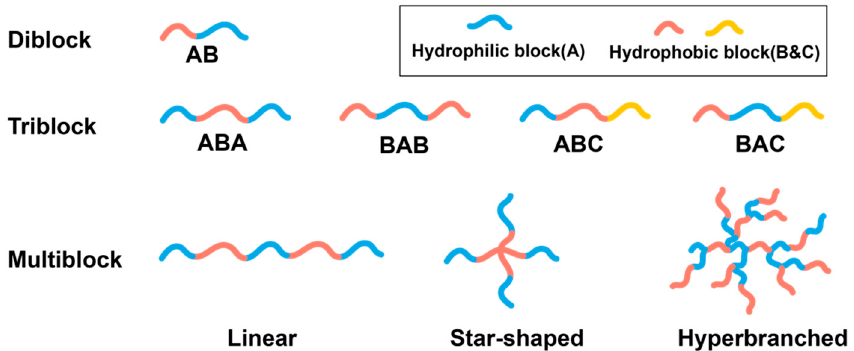
Figure 2. Polymer configurations of thermogel